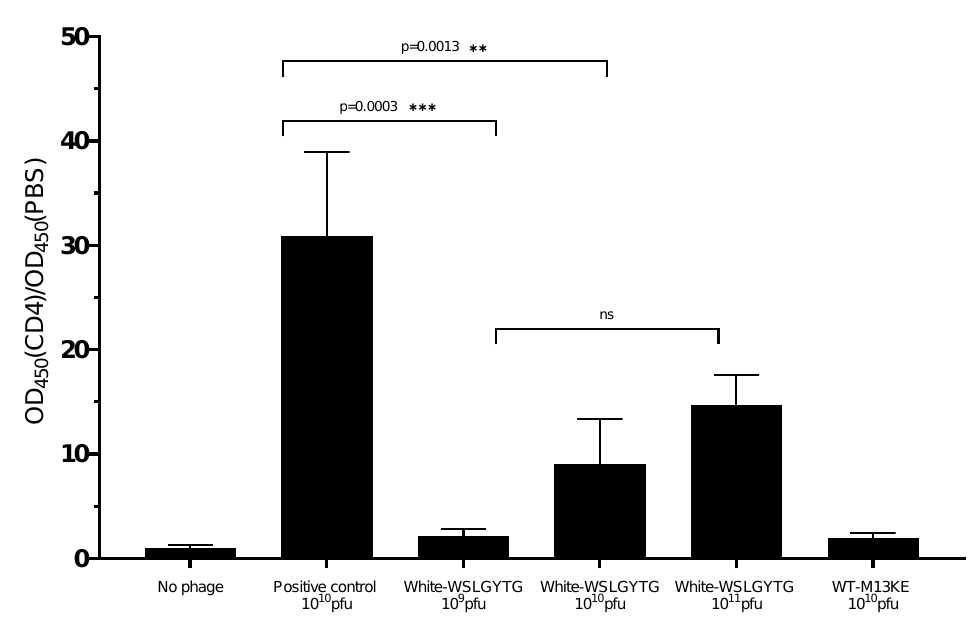
Figure 3. Evaluation of WSLGYTG-displaying white clone binding to the target protein mCD4. Target-coated wells (0, 5 µg/well) were incubated with phage clones (White-WSLGYTG, WT-M13KE, positive control, and no phage). The plate was incubated with anti-M13 antibody conjugated with HRP and color development was achieved by adding TMB and quenching with H 2 SO 4 . The absolute absorbance values (450 nm) were reference subtracted (540 nm) and binding ratio was determined through dividing clone binding by CD4-coated/PBS-coated wells (OD450 (CD4)/OD450 (PBS)). The white-WSLGYTG clone does not show significant binding to CD4 once compared with positive control. PBS: Phosphate buffered saline (no target), WT-M13KE: Ph.D. TM -7 library clone without displayed peptide, ns: non-significant.